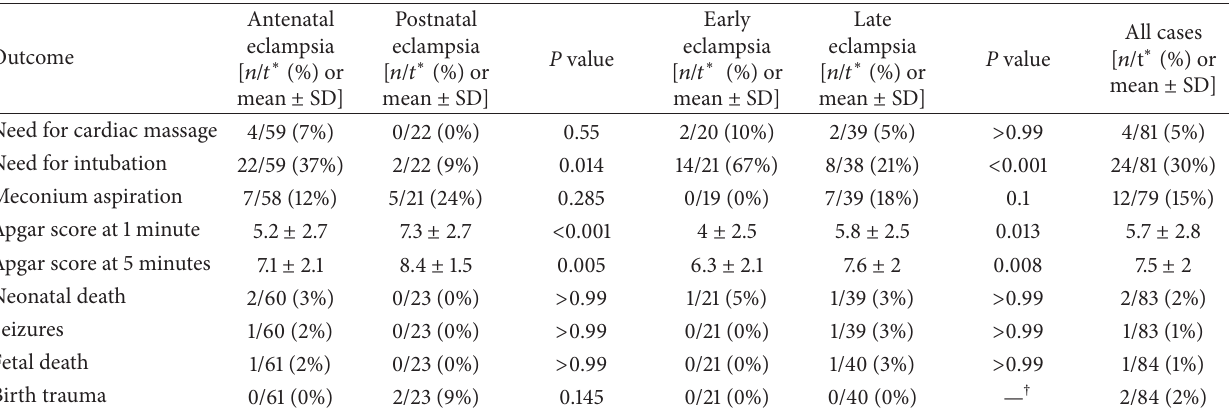
Table 3: Neonatal outcomes of eclampsia